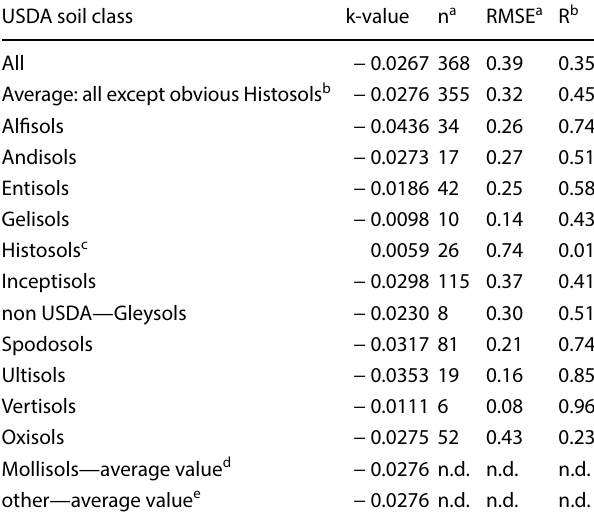
Table 4 Regression coefficients for the subsoil model in equation 2, based on the nonlinear (weighted) least-squares